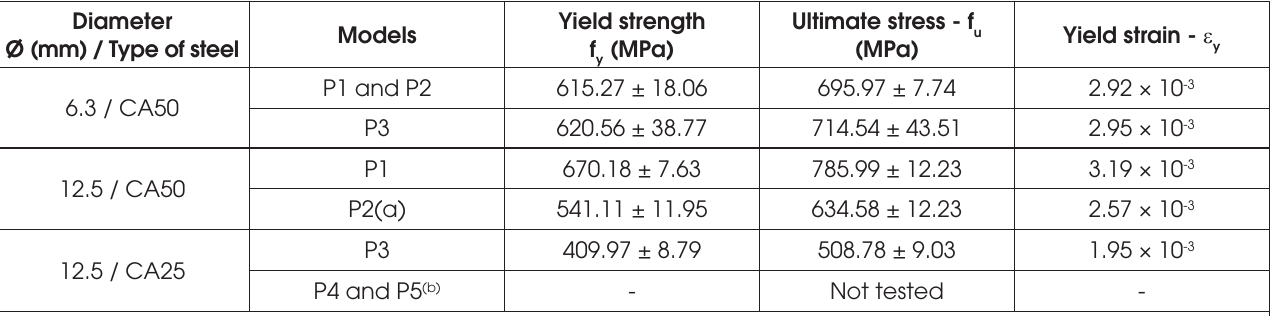
Mechanical properties of